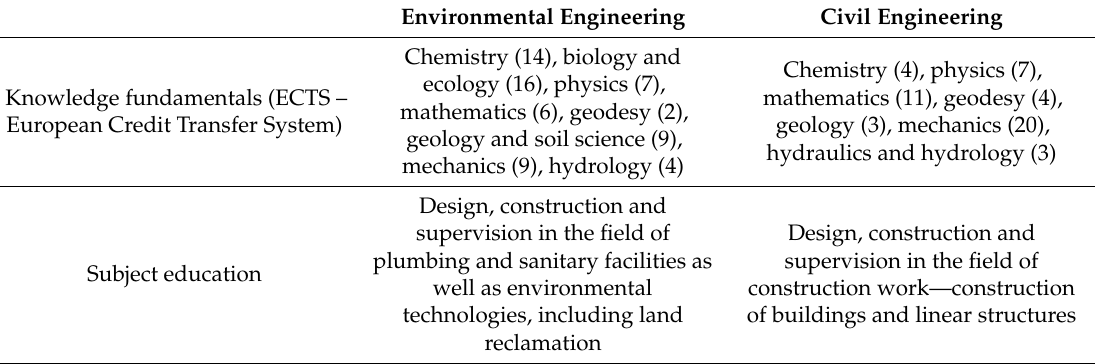
Table 1. Main assumptions and educational e ff ects of the engineer’s course (1st level course) of environmental engineering and civil engineering as specified in the educational o ff er of the University *, 2018 /